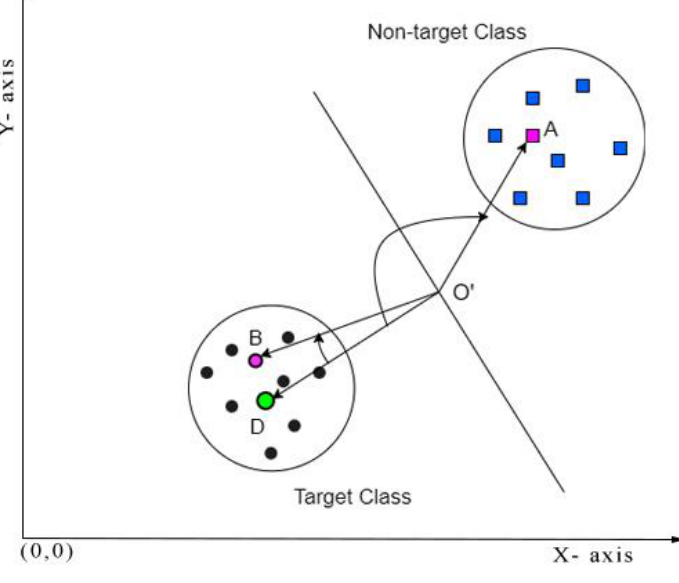
Figure 4. The solution of angle measurement problem by shifting the origin